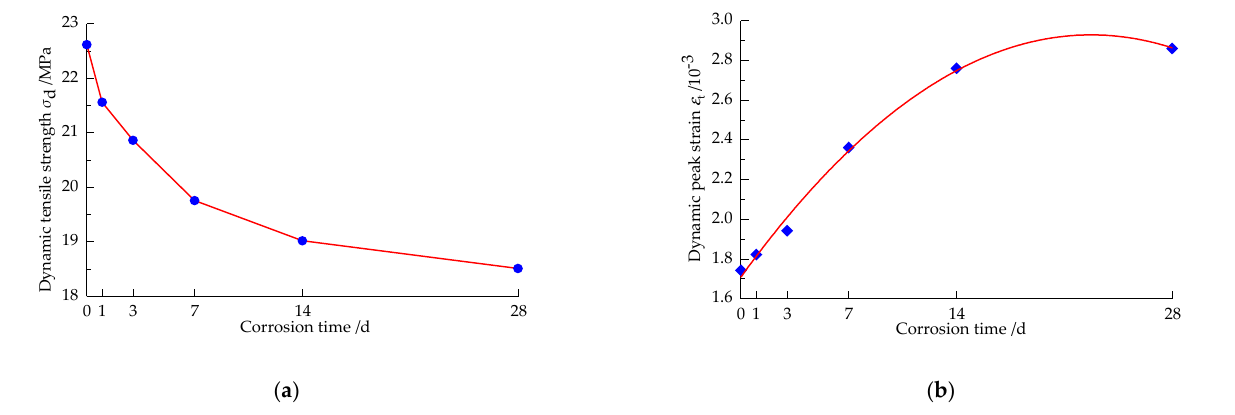
Figure 13. Changes in dynamic tensile strength and dynamic peak strain of the sandstone after different times of corrosion by the strong alkali solution. ( a ) Dynamic tensile strength. ( b ) Dynamic peak strain.